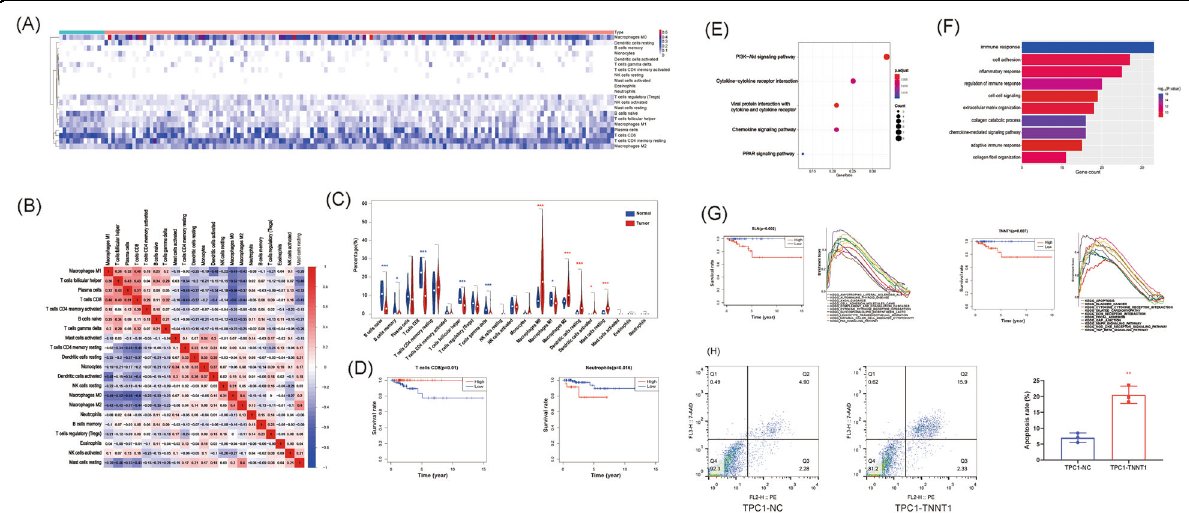
Fig. 1 Immune in fi ltration in papillary thyroid cancer is closely related to survival. A Heatmap of 22 types of immune cells in papillary thyroid cancer and healthy thyroid tissues derived from the TCGA database. B The correlation matrix of 22 types of immune cells in papillary thyroid cancer (PTC). C Comparison of each type of immune cell between PTC and healthy thyroid tissues. D The correlation of immune cells and overall survival (OS). E KEGG pathway analysis of genes associated with downregulation of CD8 + T cells. F Gene Ontology (GO) analysis of genes associated with downregulation of CD8 + T cells. G Correlation of genes associated with downregulation of CD8 + T cells and overall survival (OS), including GSEA results. H The apoptosis rated of CD8 + T cells co-cultured with TPC1-TNNT1 (overexpression of TNNT1) and TPC1-NC (negative control). (** P < 0.01, The color for */# indicates the column with the same color was